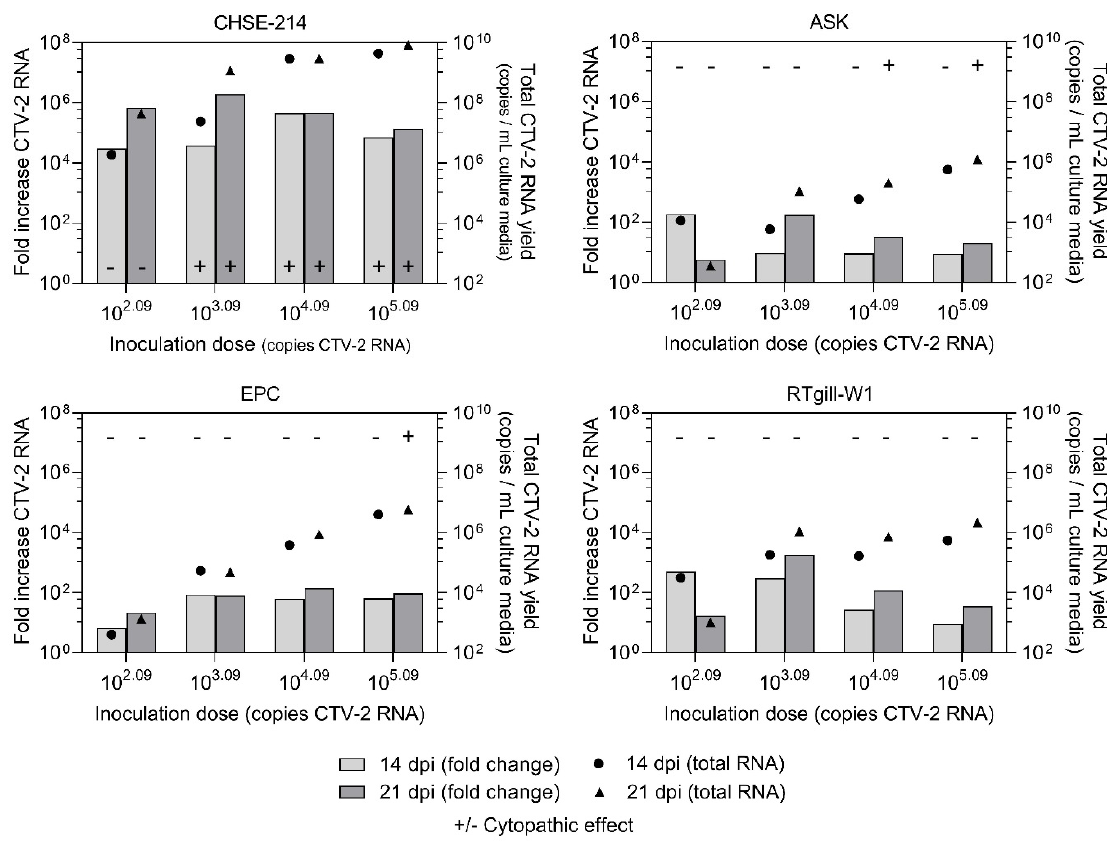
Figure 6. Quantification of CTV-2 (copies/mL culture media) in ASK, CHSE-214, EPC, and RTgill-W1 cells at 14 and 21 d post-inoculation. Plus sign denotes cytopathic effect, which was observed for that concentration at the given timepoint.